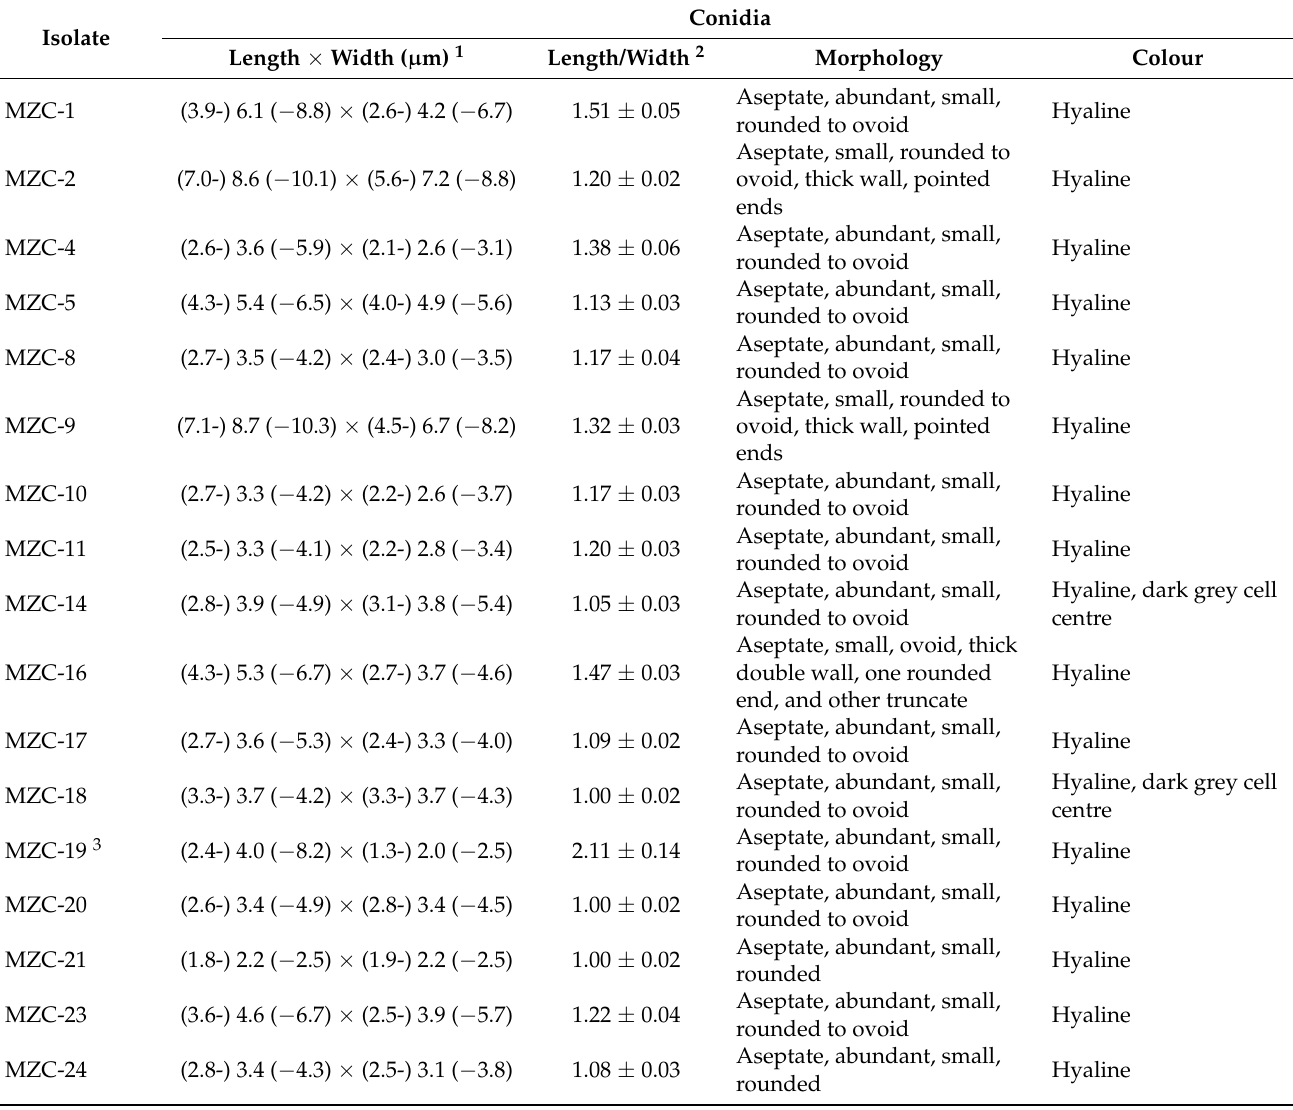
Table 4. Morphological characteristics of conidia of the fungal isolates included in this